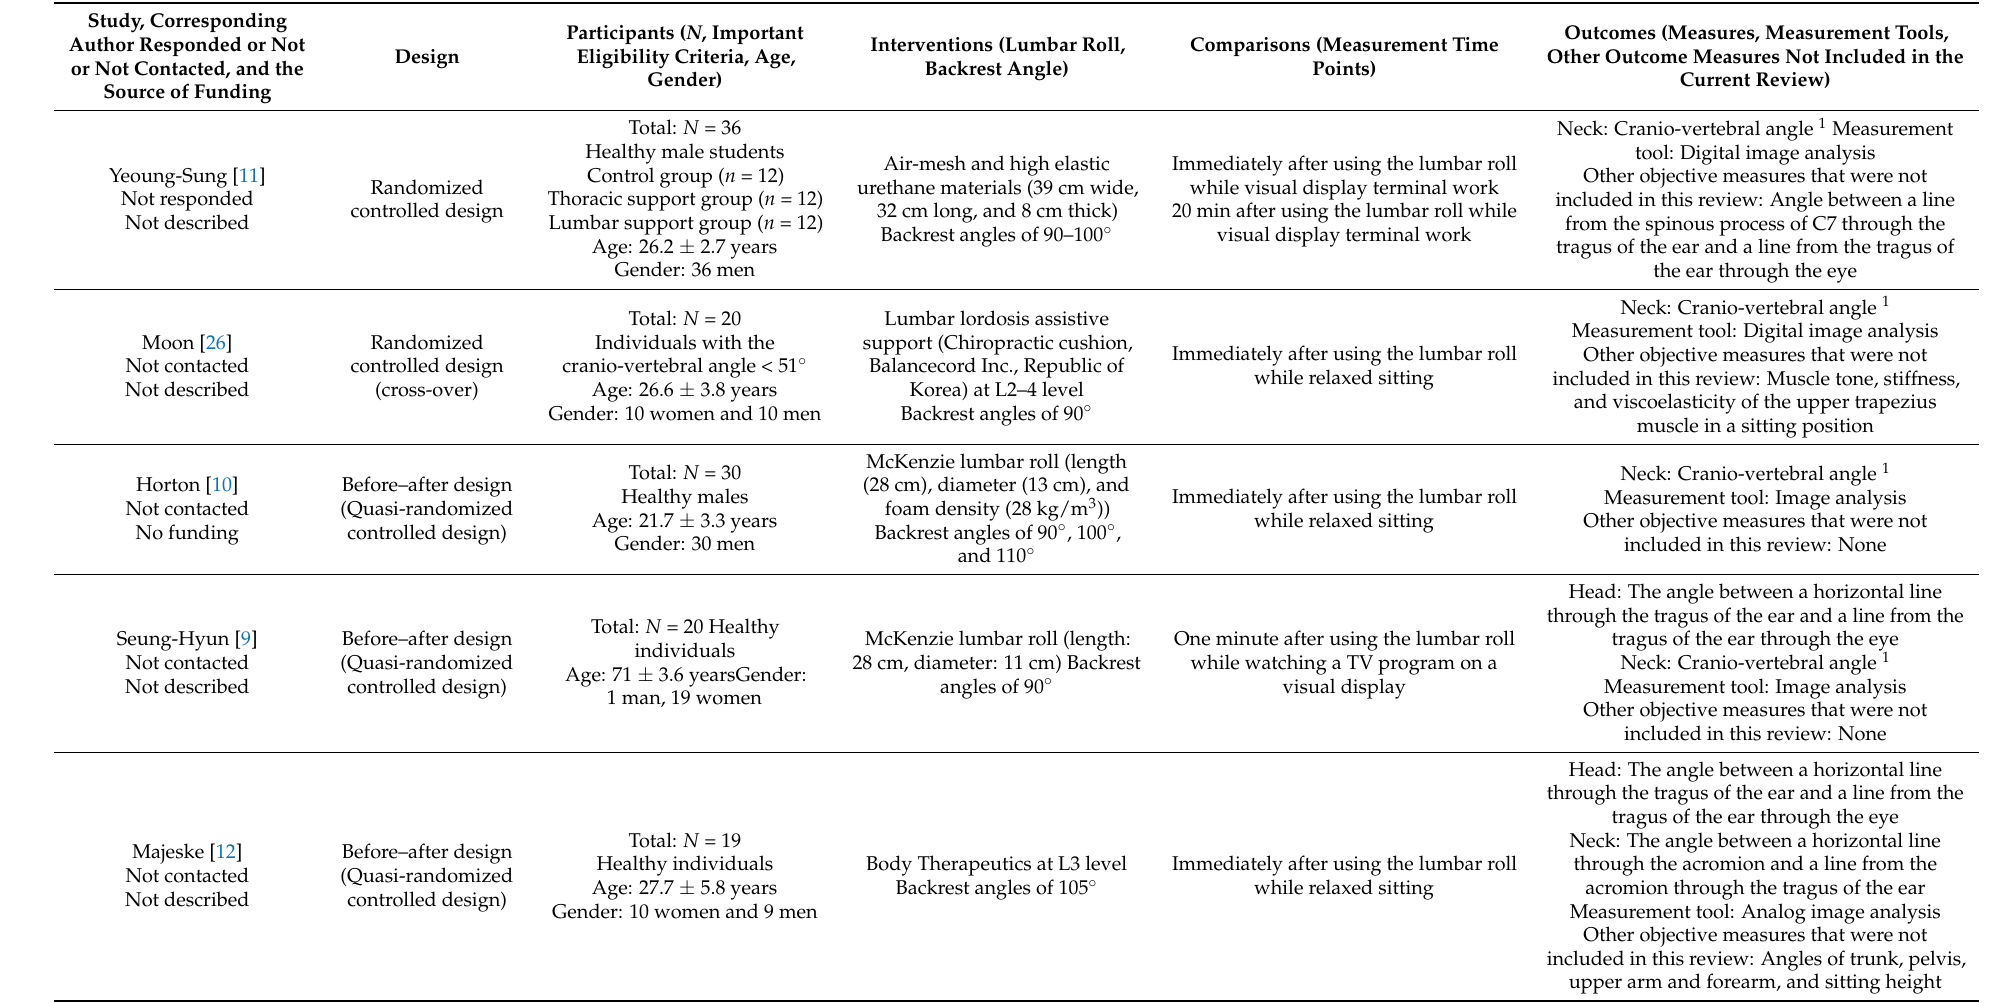
Table 1. Summary of the five studies included in the